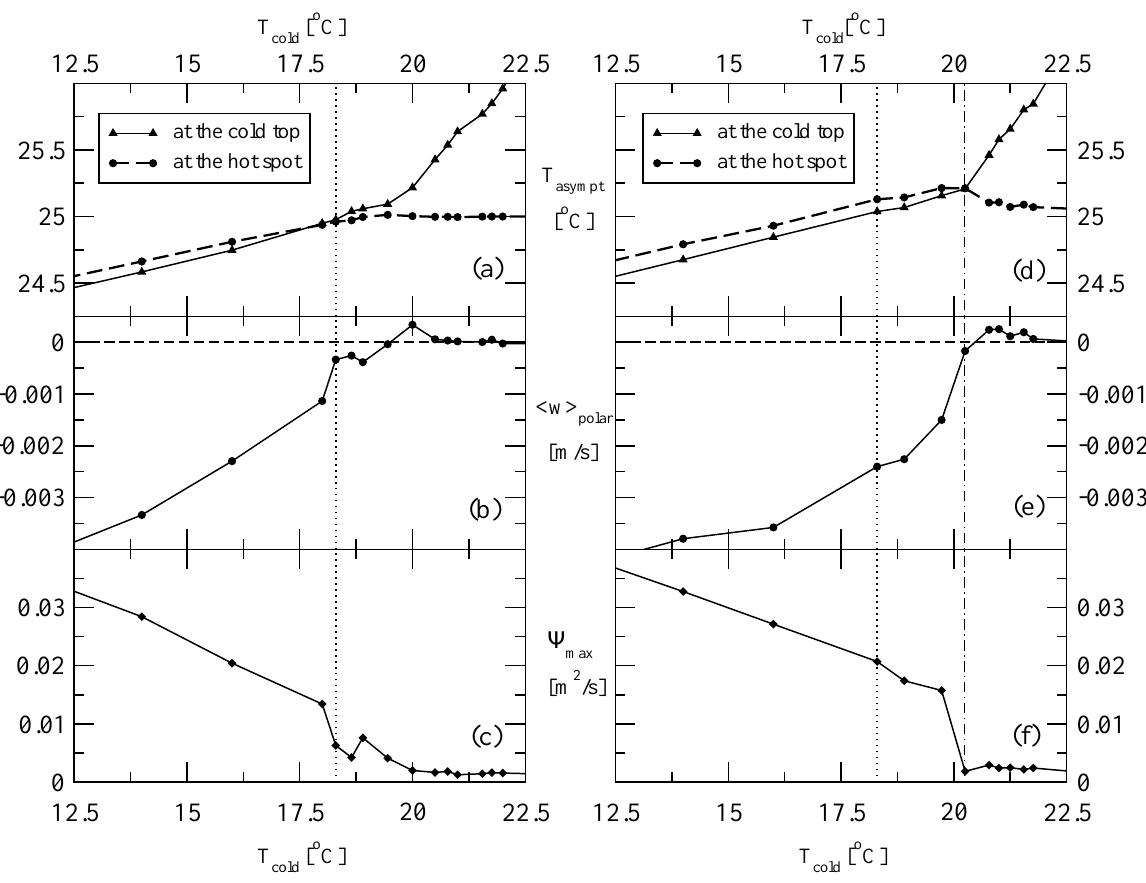
Fig. 3. The T cold dependence of three parameters that characterize the transition between the convection states. As in Fig. 2, the left column corresponds to the “no hot spot” scenario, and the right column shows the T spot = 30 ◦ C case. Figures 3a and d represent the quasi-equilibrium temperatures at the right (cold) margin of the basin at the surface and at the bottom. Figures 3b and e depict the vertical velocity ( h w i polar ) averaged over the region that is indicated in Fig. 2. The maxima of the streamfunctions ( Ψ max ) are shown in Figures 3c and f. The dashed and dashed-dotted vertical lines mark the critical T cold , where the onset of DWF takes place in the “no hot spot” and in the “hot spot” case, respectively.